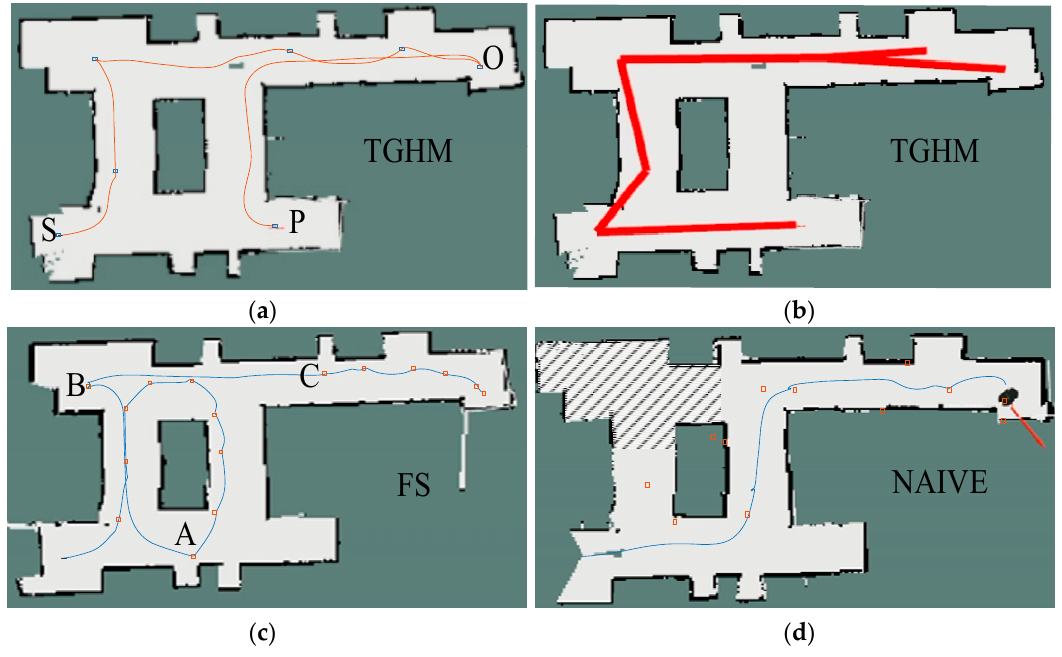
Figure 13. Trajectory graph: ( a ) TGHM; ( b ) grid–topology hybrid map; ( c ) FS; ( d ) Naïve.